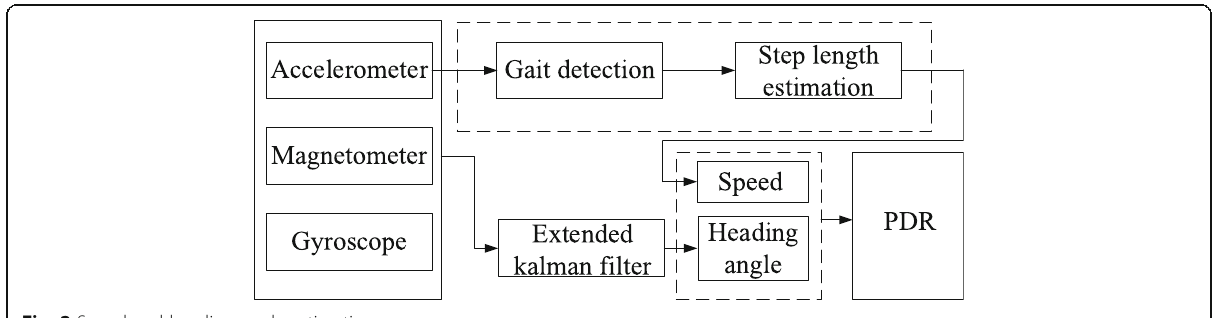
Fig. 2 Speed and heading angle